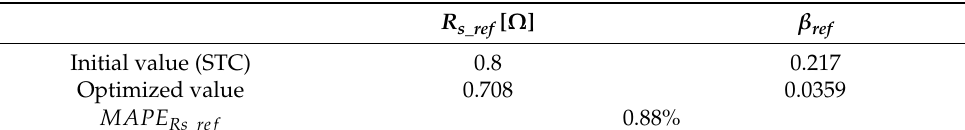
Table 7. Extracted reference values for constant T pv for the series resistance model. Table 7 . Extracted reference values for constant 𝑇 (cid:3043)(cid:3049) for the series resistance model.